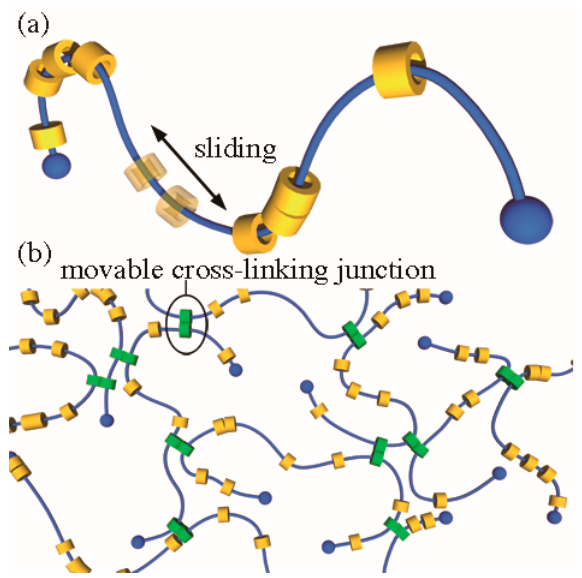
Figure 1. Schematic illustrations of ( a ) PR and ( b ) SR gels.